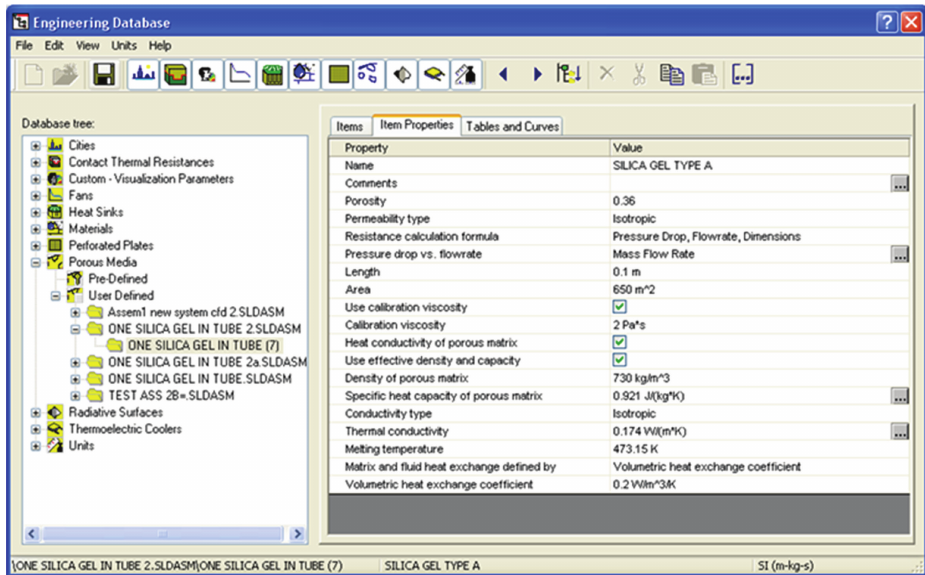
Figure 8: To define a porous medium in this simulation you need to specify the porous medium’s properties (porosity, permeability type, etc.) in the engineering database and then apply the porous medium to a silica gel in the assembly see Figure 8.